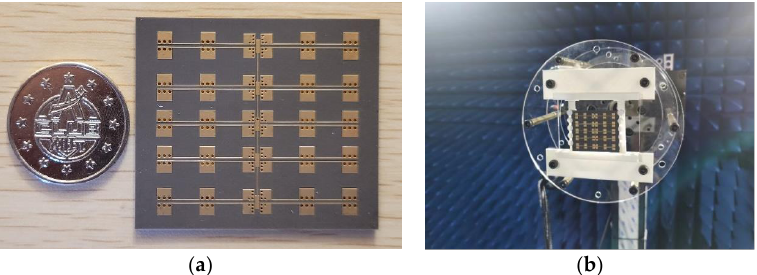
Figure 9. The simulated co-polarization radiation patterns in the E plane at 28 GHz versus l.